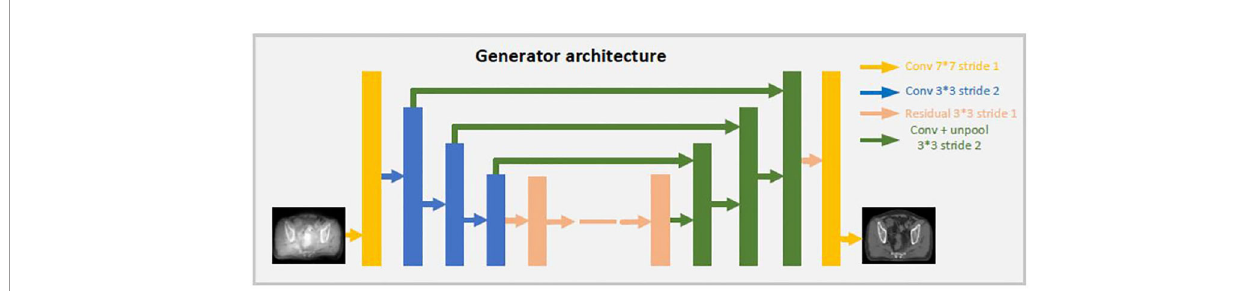
FIGURE 2 | Architecture of